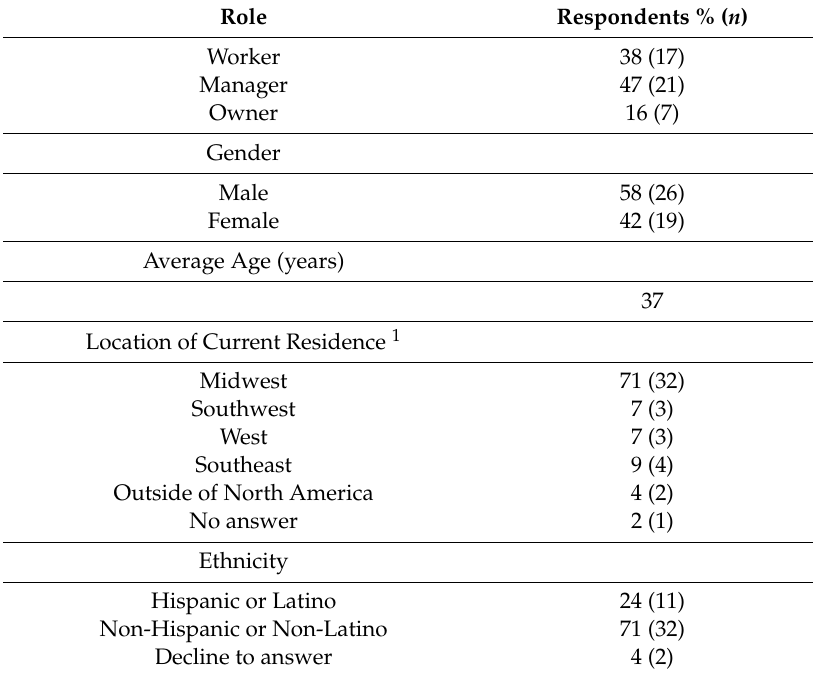
Table 1. Demographics of survey respondents ( n =